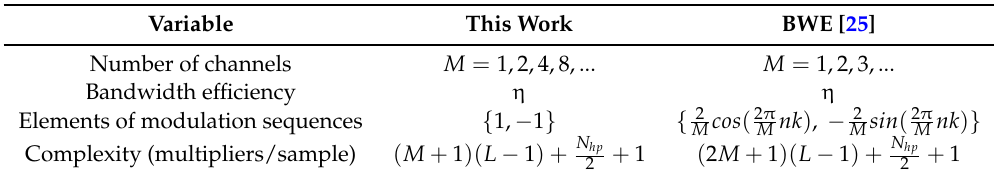
Table 1. Comparison. BWE, bandwidth